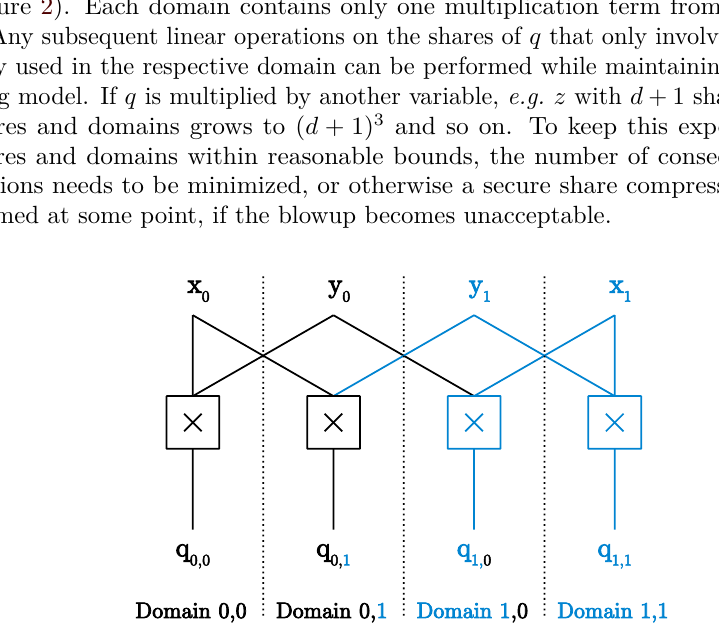
Figure 2: First-order low-latency multiplication with compression skipping, resulting in four